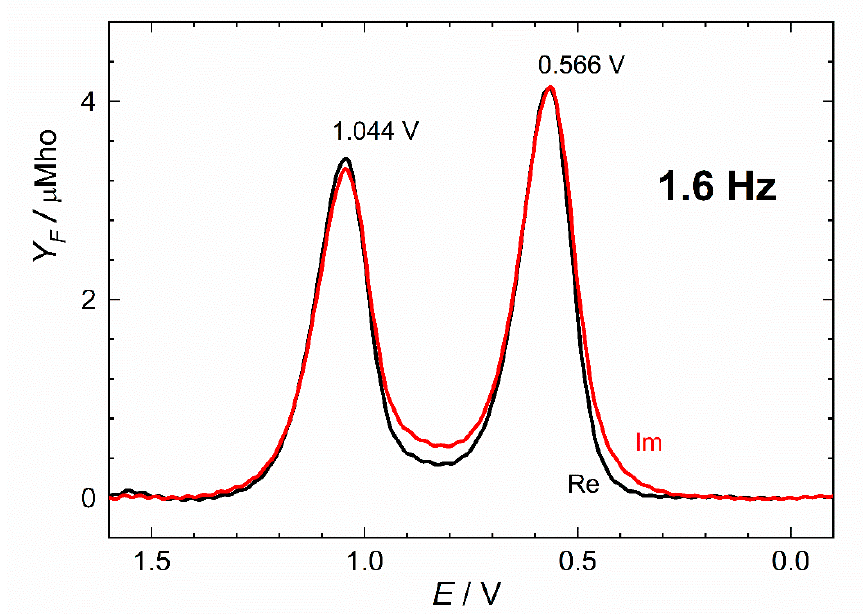
Figure 4. AC voltammogram at 1.6 Hz shows the faradaic part of the admittance vector of ligand 1 (DCE/Bu 4 NPF 6 ). The real (Re) and imaginary (Im) components are black and red curves, respec- tively.